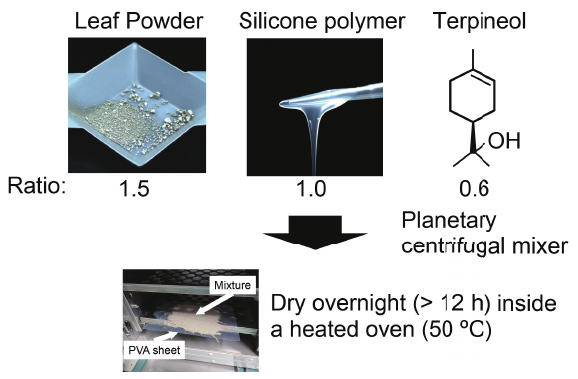
Figure 1. Sensor fabrication procedure.